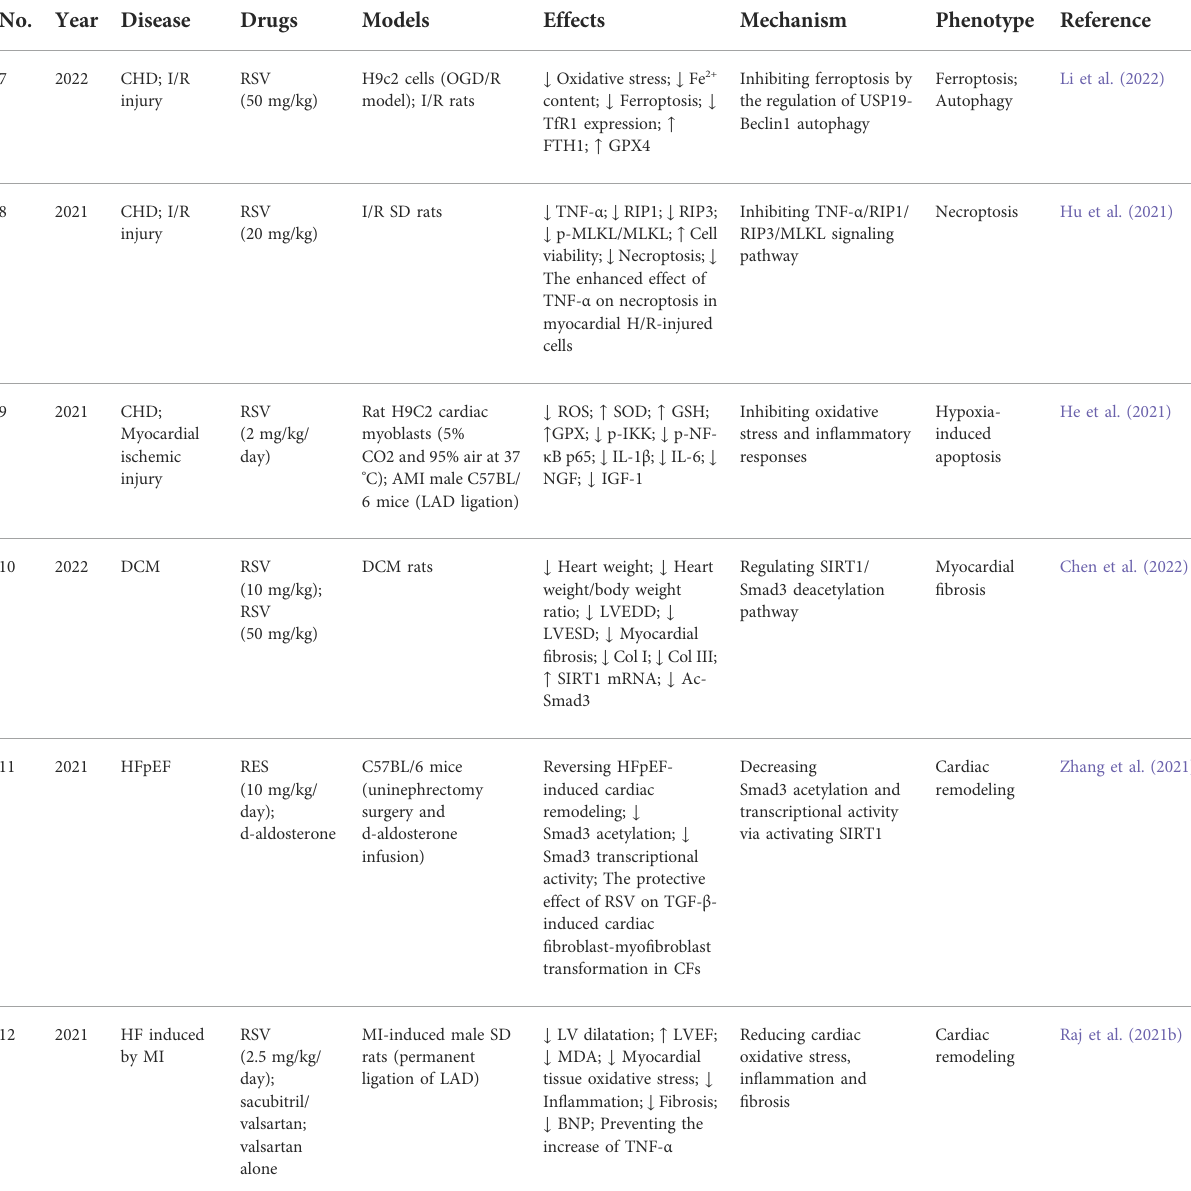
TABLE 2 ( Continued ) Molecular mechanism of resveratrol in different cardiac remodeling phenotypes of independent cardiovascular disease in recent 1